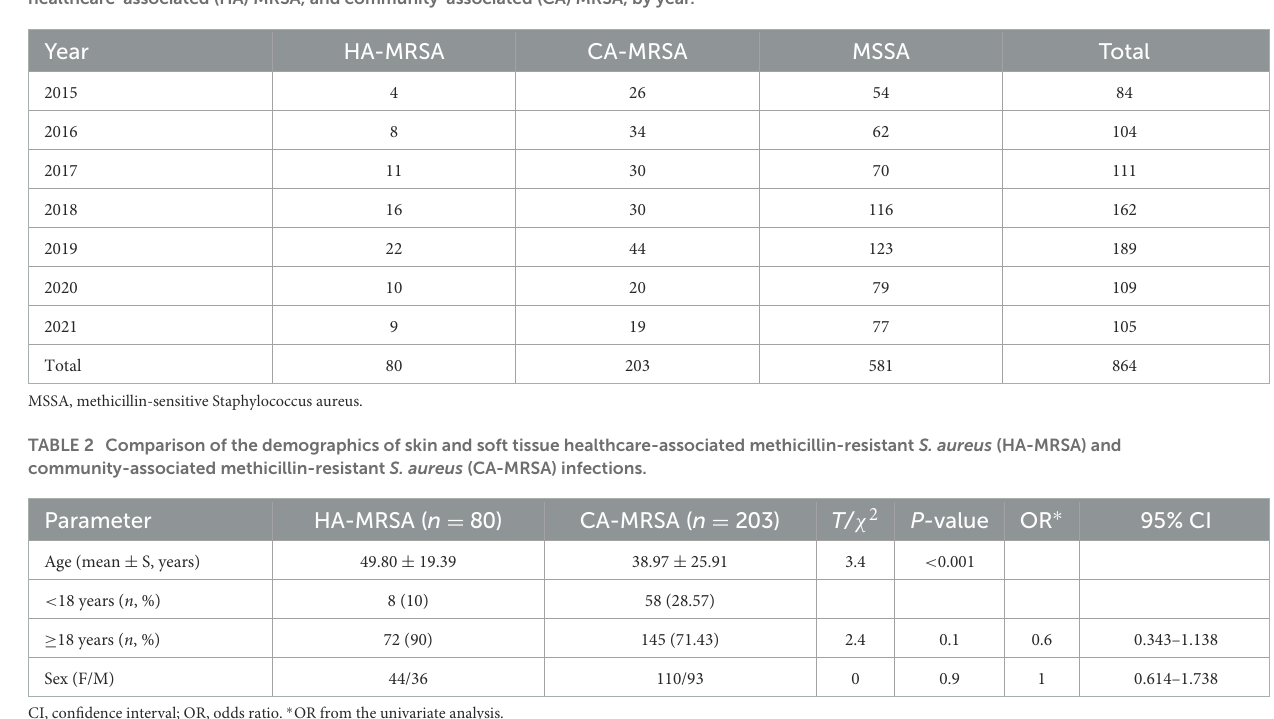
TABLE 1 The number of patients with skin and soft tissue Staphylococcus aureus infection, including that by methicillin-resistant S. aureus (MRSA), healthcare-associated (HA) MRSA, and community-associated (CA) MRSA, by year.